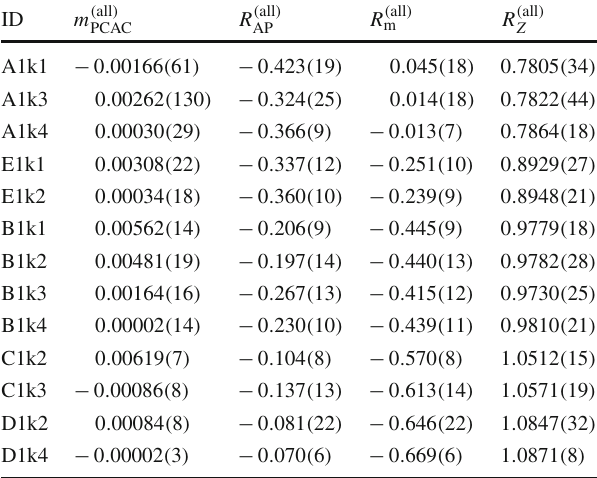
Table 8 Sea quark PCAC masses and estimators R AP , R m and R Z for LCP-1 (i.e., at the partially-quenched point) for all topological sectors